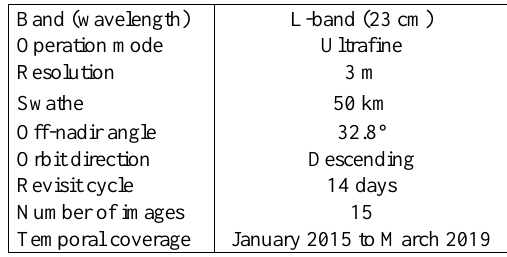
Table 1. Acquisition parameters of the ALOS-2 PALSAR-2